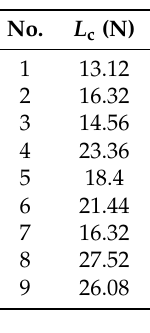
Figure 3. Scratch morphology and Fe elemental content diagram of the TiAlN/TiN multilayer coating. Table 4. Adhesion of the TiAlN/TiN multilayer coating.